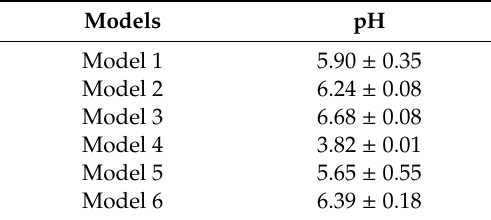
Table 4. Value of soil pH in the farming